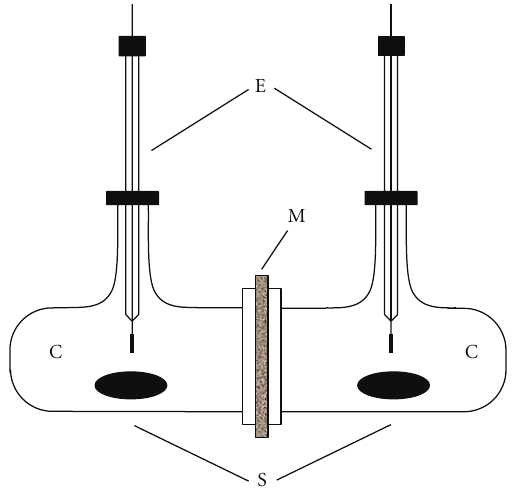
Figure 4: Evolution of the emf of the P5FNDIHS membrane for di ff erent c 2 /c 1 ratios: ( (cid:2) ) 0.01/0.005, ( • ) 0.02/0.01, ( (cid:5) ) 0.1/0.05, ( (cid:3) ) 0.2/0.1, ( (cid:2) ) 0.4/0.2, ( (cid:4) ) 0.8/0.4, and ( ♦ ) 1.0/0.5.